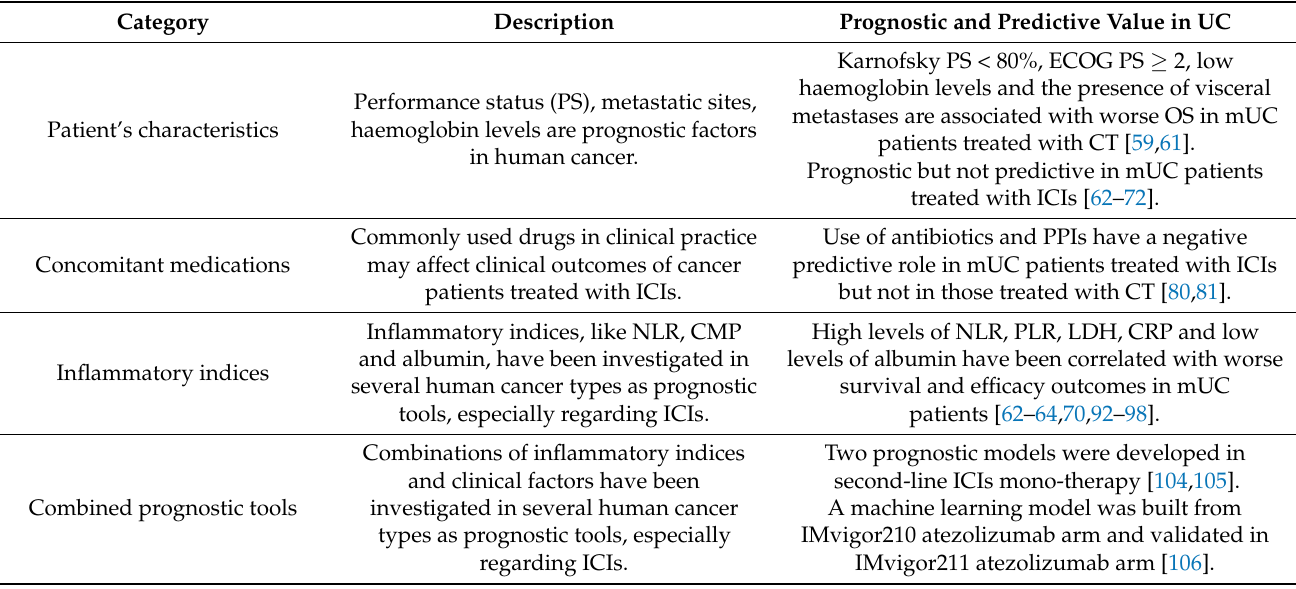
Table 2. Clinical factors and their prognostic and predictive value in UC patients, with a particular focus on ICIs.